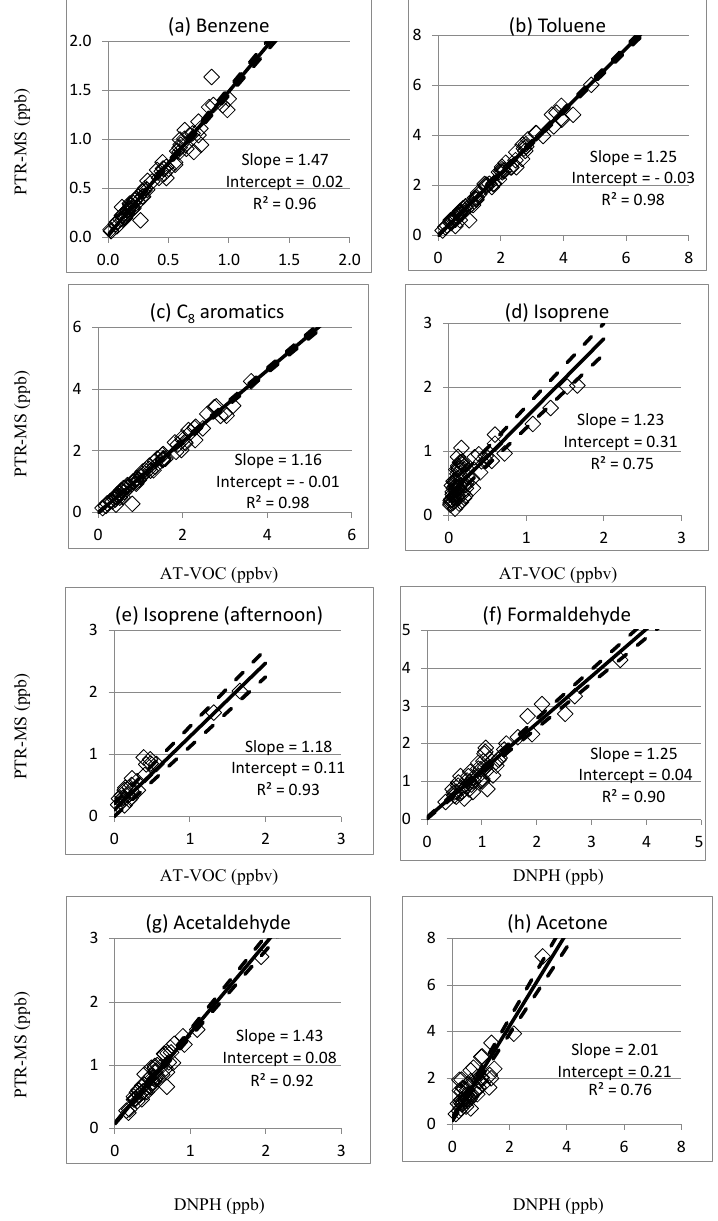
Figure 1. Intercomparisons of PTR-MS vs. AT-VOC and DNPH measurements of selected VOCs in SPS 2 (2012). RMA correlation coeffi- cients ( R 2 ) and regression fits are indicated (solid line) plus or minus the standard error (dashed